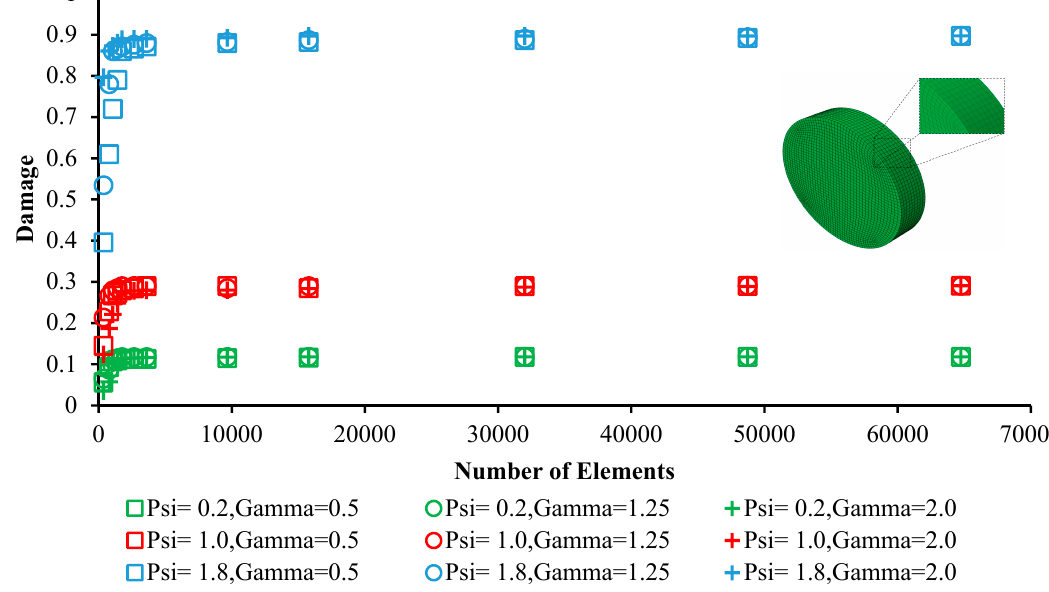
Figure 5. Mesh convergence analysis of the corroding Mg–1.2Zn–0.5Ca (wt.%) coupon in corrosive environment (SBF solution) at 37 °C. The meshed coupon is also presented in the figure.